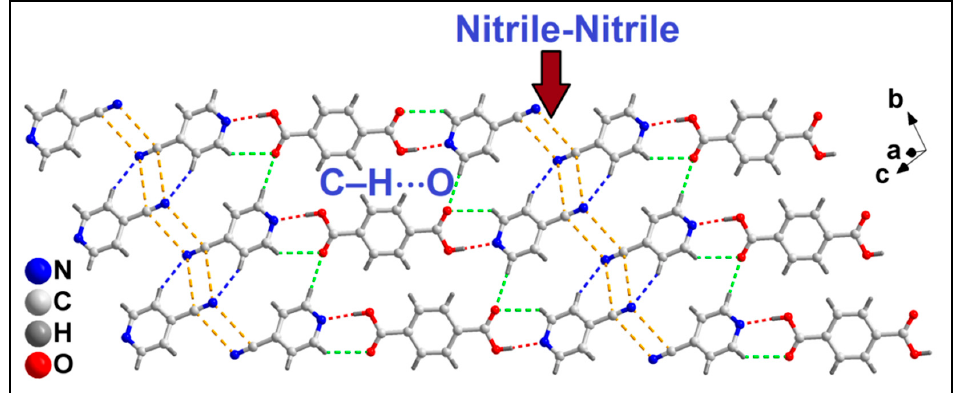
Figure 4. Layered assembly of co-crystal 3 along the crystallographic bc plane.